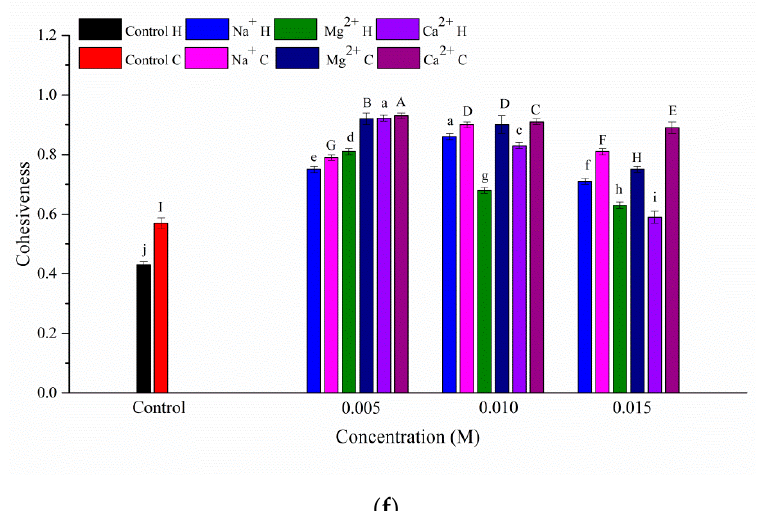
Figure 1. Heat- and cold-induced gel textures from salt ions applied before spray drying. ( a ) Hardness; ( b ) Springiness; ( c ) Chewiness; ( d ) Resilience; ( e ) Gumminess; ( f ) Cohesiveness. All samples are average values ± standard deviation ( n = 3), and different letters in the same figure represent a significant difference between samples ( p < 0.05). Capital letters represent cold-induced gels and lower case letters represent heat-induced gels. C represents cold-induced gels; H represents heat-induced gels.